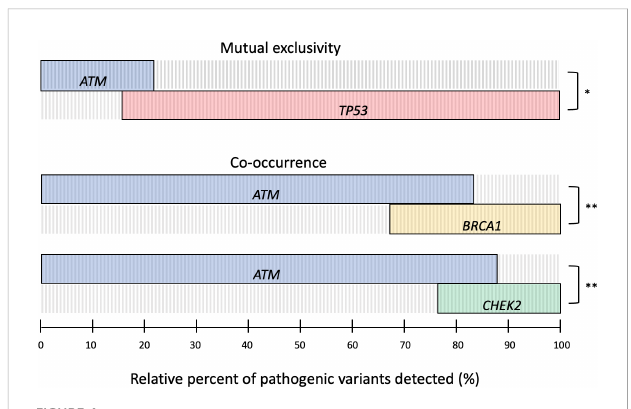
FIGURE 4 Oncoprint plot of somatic pathogenic alterations in ATM, TP53, BRCA , and CHEK2 across relevant tumor sequencing data to determine the relationship between alterations. Log2 odds ratio was used to identify mutual exclusivity and co-occurrence, with signi fi cant differences de fi ned by Benjamini-Hochberg FDR correction (* q ≤ 0.05, ** q ≤ 0.01, *** q ≤